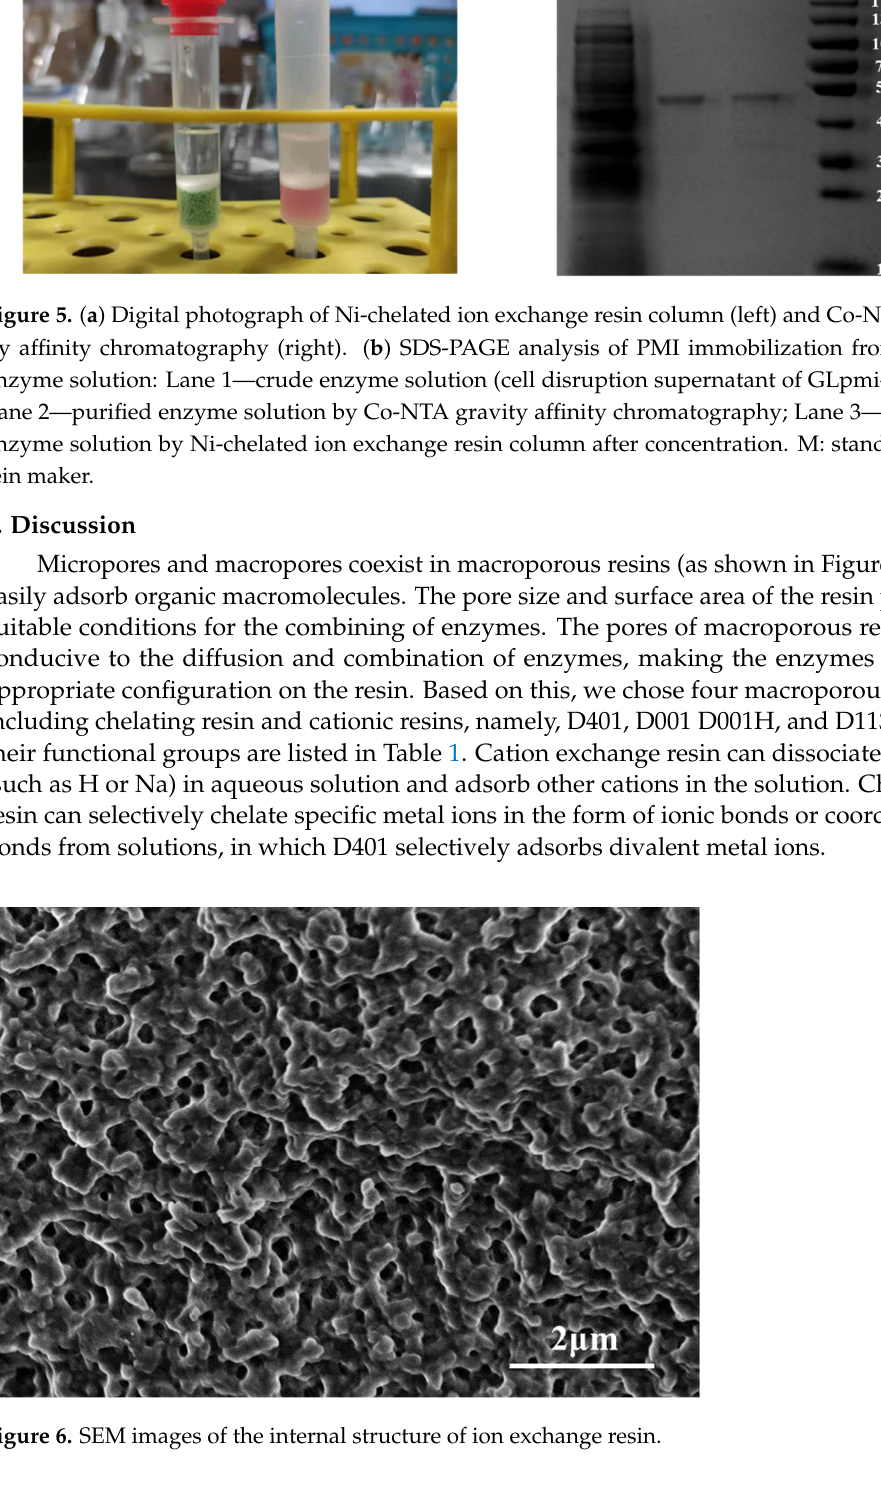
Figure 4. ( a ) Reusability of F6P reaction catalyzed by immobilized enzymes, ( b ) thermostability of immobilized enzymes and free enzymes incubated 2 h at different temperature, and ( c ) pH stability of immobilized enzymes and free enzymes incubated 2 h at different pH.